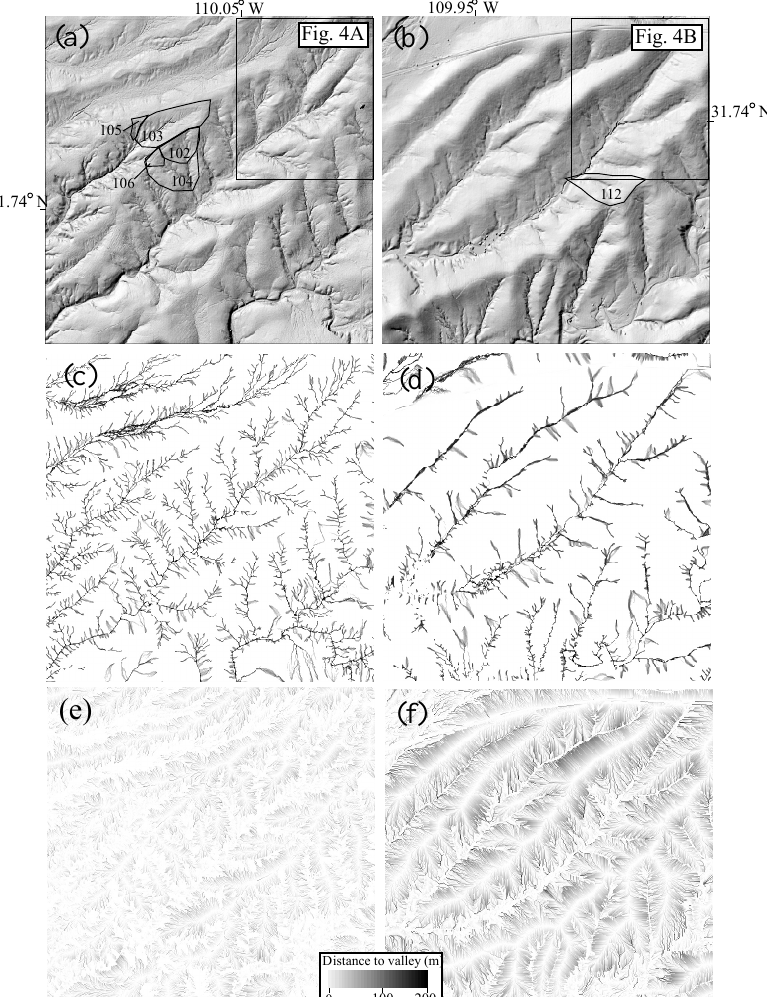
Figure 3. Drainage density is higher in shrubland areas than in grassland areas of the study site. Shaded relief images of representative 1.6km × 1.6km areas of (a) shrublands, including Lucky Hills watersheds 102–106, and (b) grasslands, including Kendall watershed 112. (c) and (d) Images of the drainage network identified using the Pelletier (2013) algorithm for the areas shown in (a) and (b) , respectively. (e) and (f) Grayscale maps of the distance along flow lines from divides to the valley bottom. The mean of the mapped values in (e) at valley heads is 18m while the mean of the mapped value in (f) at valley heads is